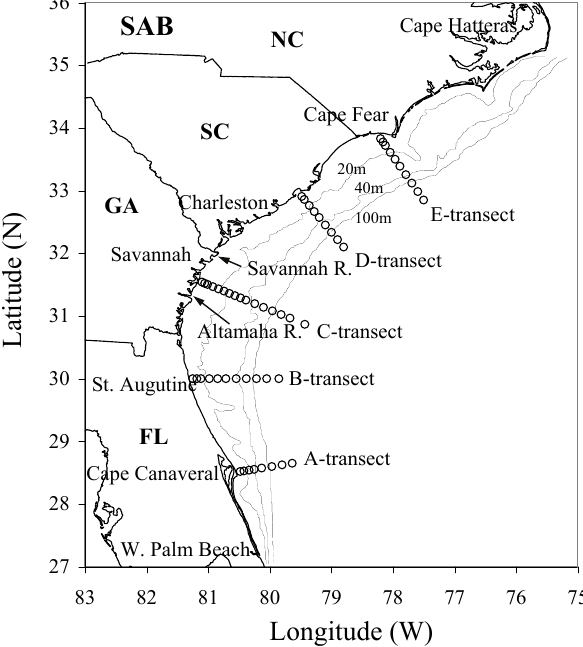
Fig. 1. Study area in the US South Atlantic Bight between Cape Lookout, North Carolina, and Cape Canaveral, Florida. Open circles indicate sampling stations, between the shoreline and extending to ∼ 500m water